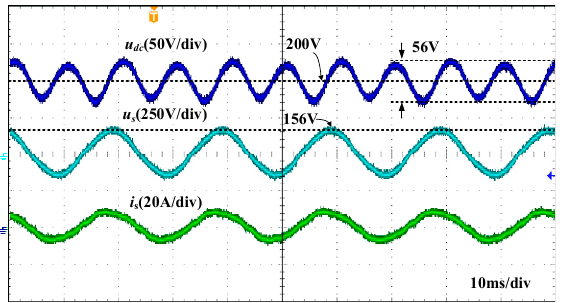
Figure 9. Experiment waveforms of input voltage u s , input current i s , and output voltage u dc without the power decoupling circuit.